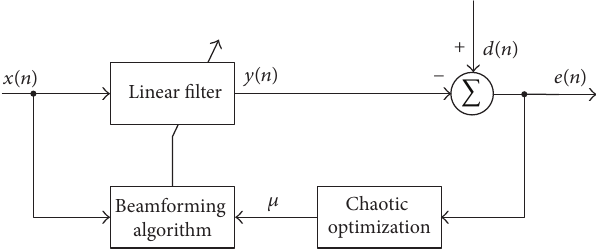
Figure 2: Block diagram of the Chaotic beamforming algorithm.